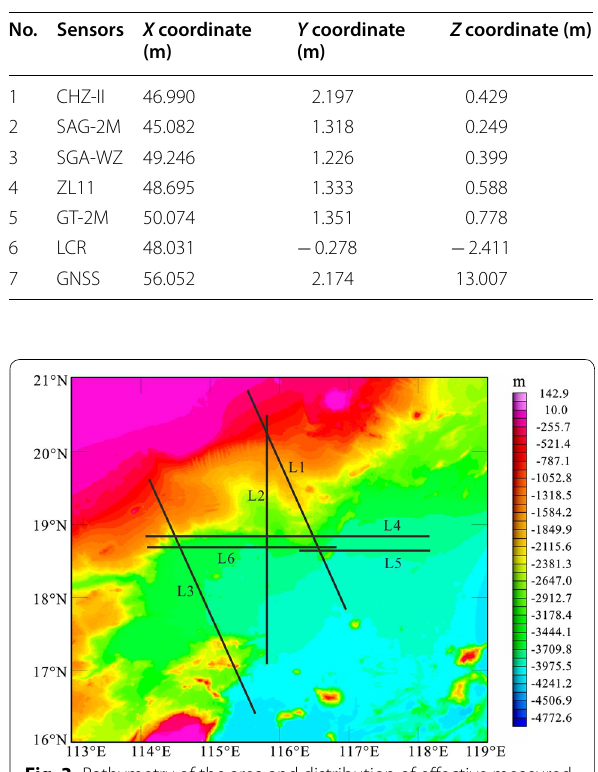
Table 1 Position coordinates of sensors in the vessel coordinate system